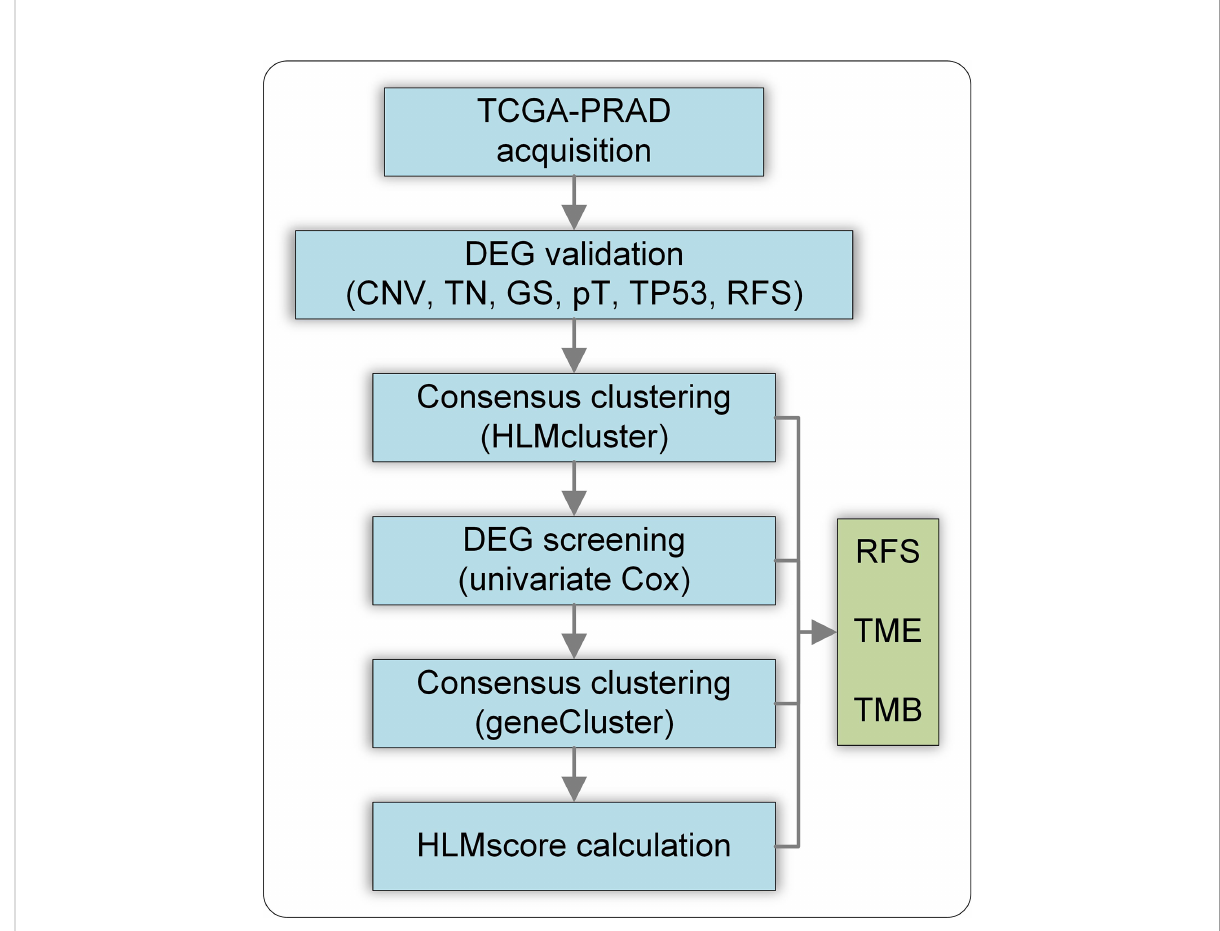
FIGURE 1 Flow chart of this study. CNV, CNV loss or gain; TN, tumor vs. normal; GS, GS >7 vs. GS< 7; pT, pT3 vs. pT2 (pT); TP53, TP53 mutation vs. wild type; RFS, RFS high vs. low expression of